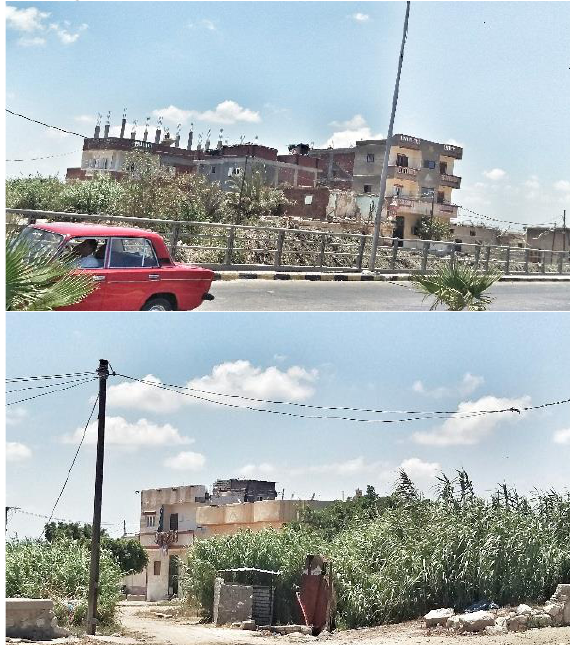
In 2004, urban growth pattern in Al-Maamoura could be categorized as scattered built up areas, where families working on the agricultural land gathered in groups of small rural houses see figure 7. These houses where registered and organized through the governorate with supply of fundamental amenities like electricity and sewage.